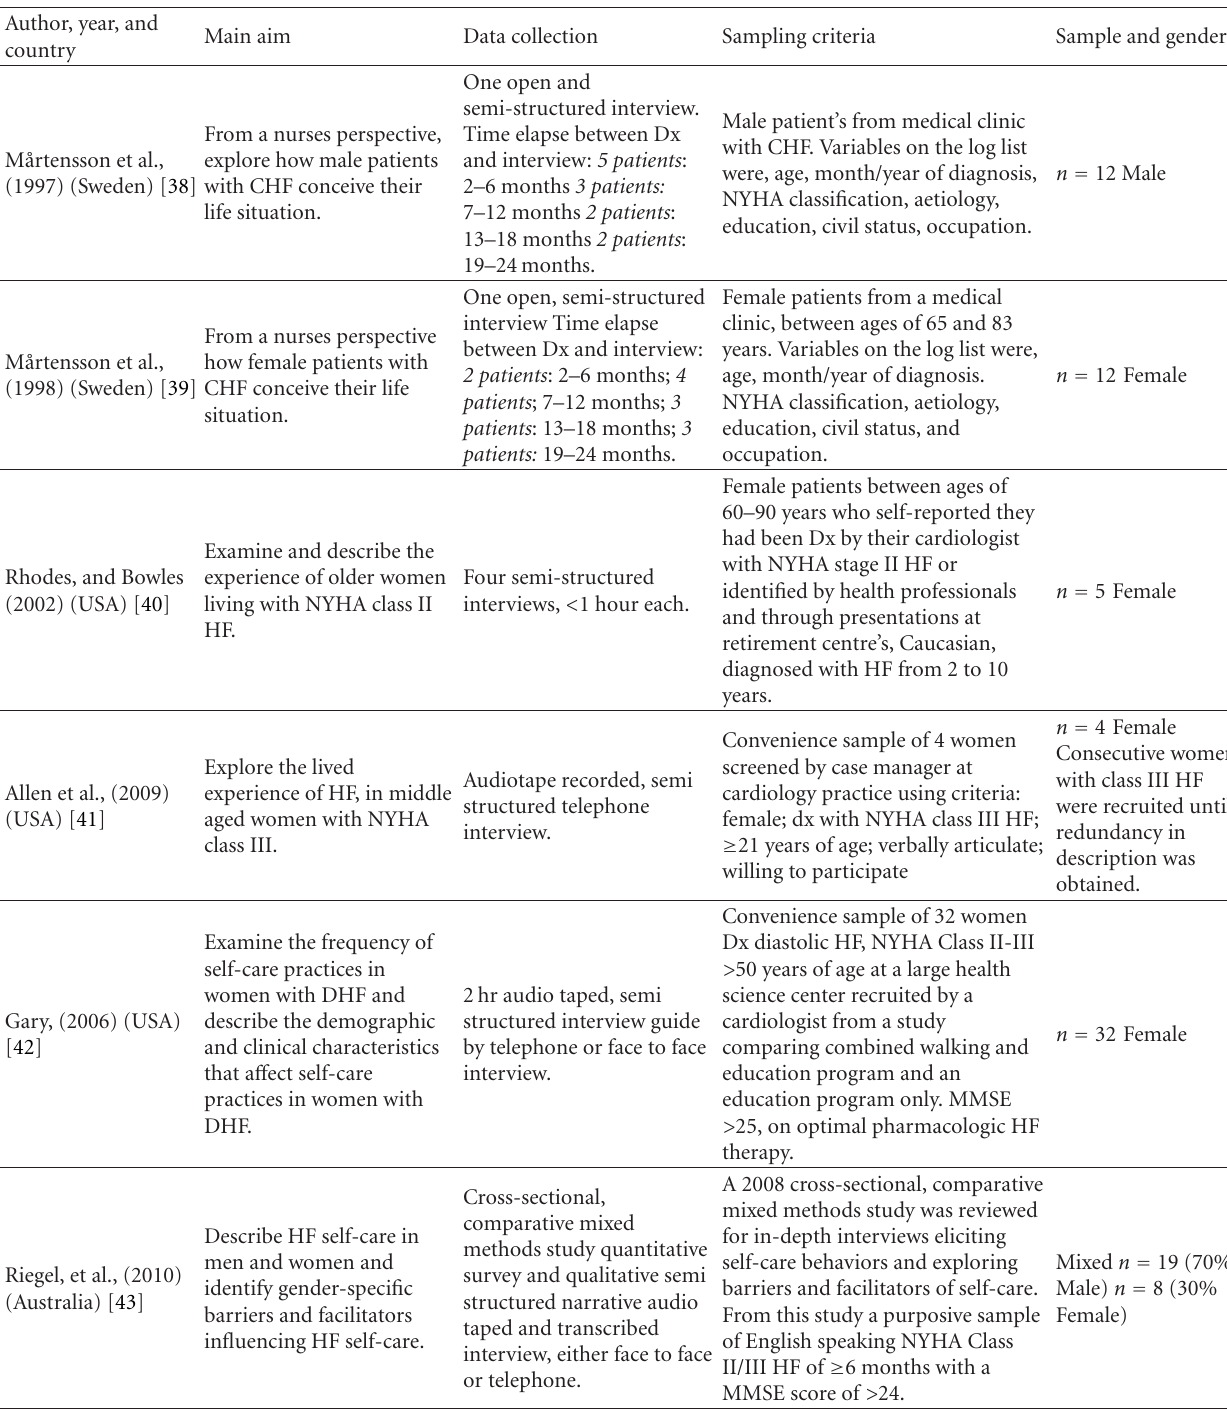
Table 1: Summary of included